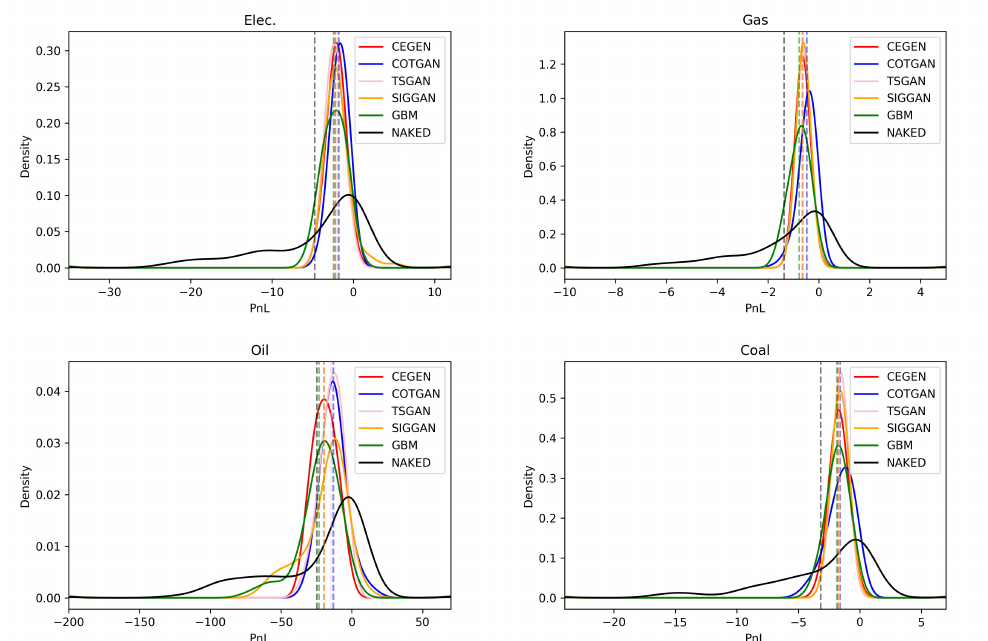
Figure 4. PnL distributions for at-the-money call option hedging. Vertical lines represent the means of the associated